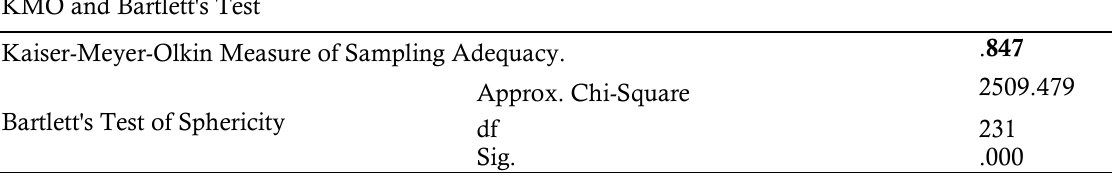
Table 1. KMO and Bartlett's